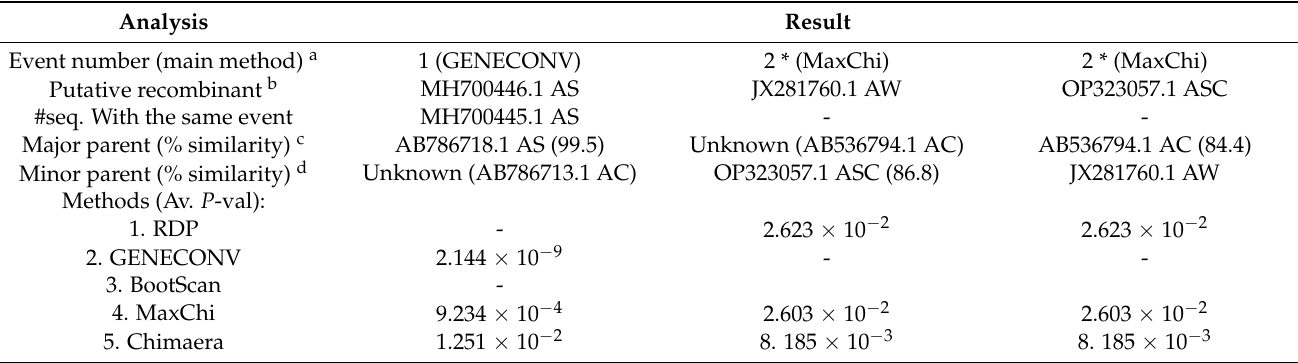
Table 3. Intragenic recombination in mtCOI (COI-2) by using nine different methods implemented in RDP5